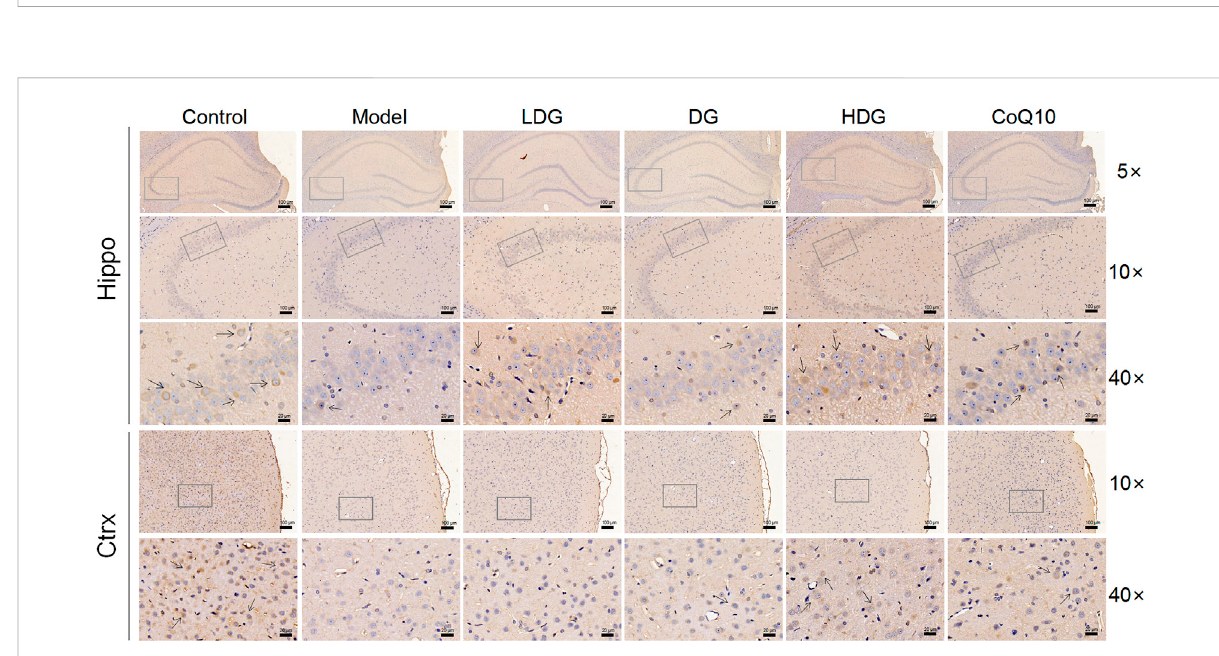
FIGURE 8 Immunohistochemical staining for NMDAR2B in the hippocampal CA3 region (×5, ×10, ×40 magni fi cation) and the prefrontal cortex stromal layer (×10, ×40 magni fi cation) of